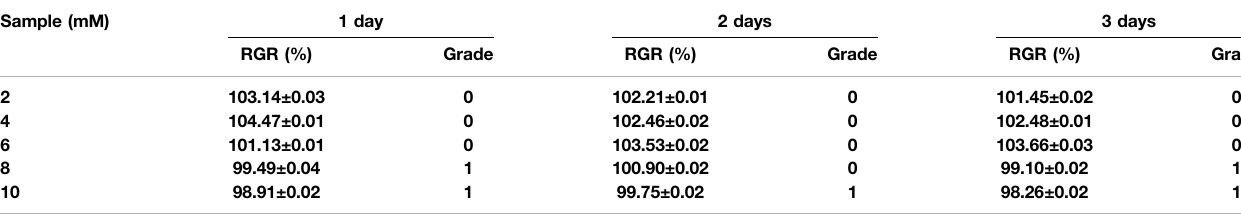
TABLE 2 | RGR and the cytotoxicity level of MC3T3-E1 cells cultured with gradient Mg 2+ concentrations at different detection periods. Sample